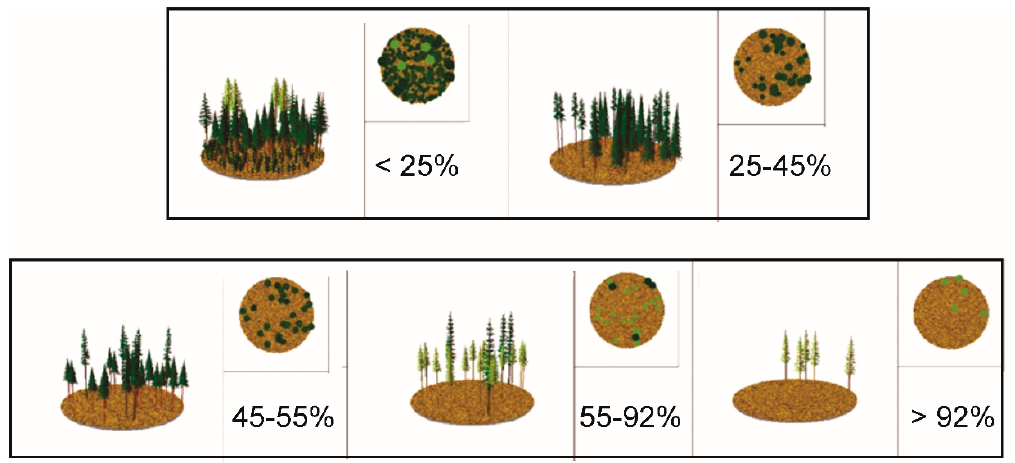
Figure A1. Examples of different canopy openings (%) using the Stand Visualization System [25]).